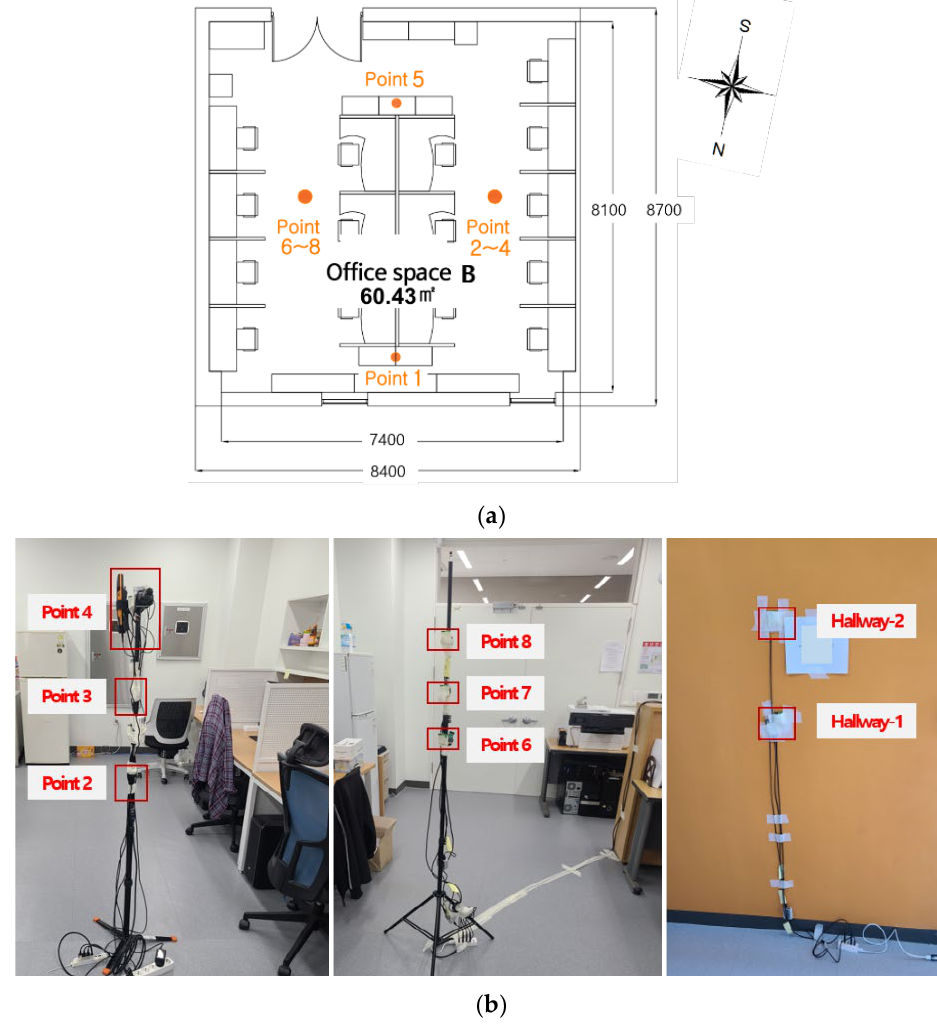
Figure 14. Indoor air quality measurement of Office Space B: ( a ) Office Space B plane view and measurement locations and ( b ) Photos of indoor air quality measurement experiment on 10 August 2021. According to the results of the analysis of the comfort level in Office Space B, similar to the previous one-person office space, the comfort range was PMV = − 0.32, as shown in Figure 15 [31,32].